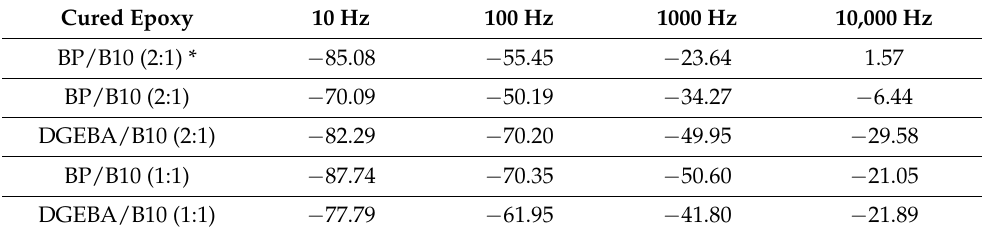
Table 10. Sub-glass transition temperature of cyanate ester-cured epoxy resin at 2:1 and 1:1 at different frequencies.